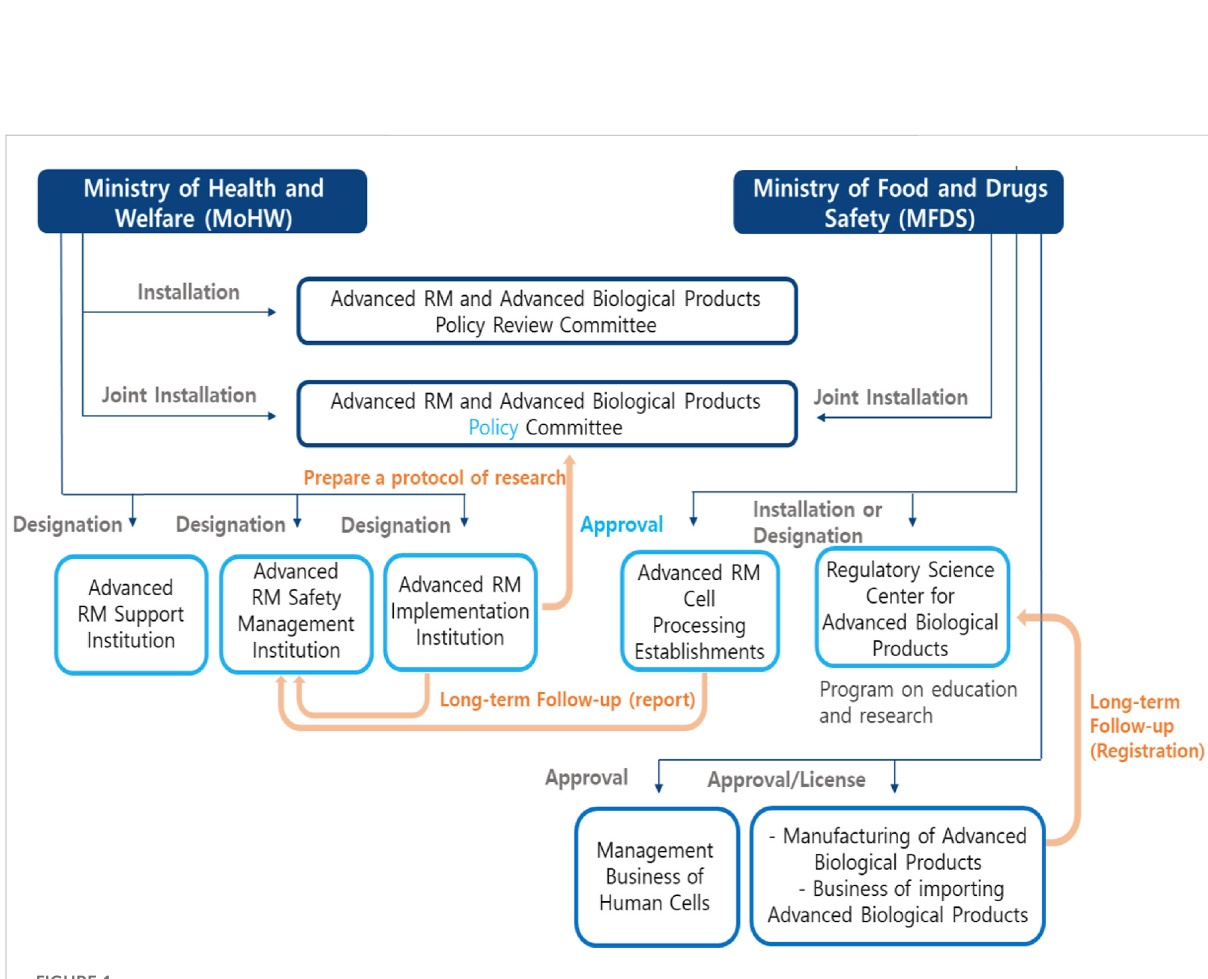
FIGURE 1 Relevant institutions of Advanced RM and Advanced